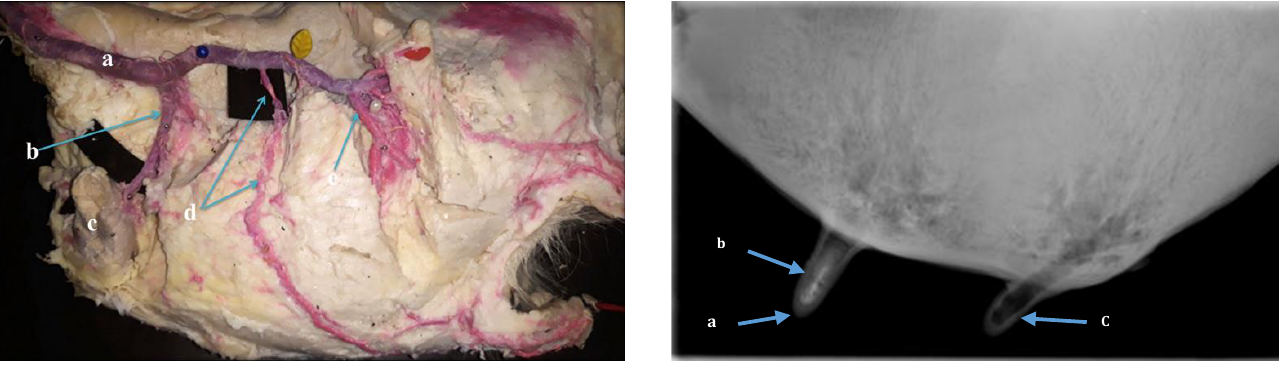
Figure 6. Radiographic picture of the fore quarter in non-lactating udder (1 mL of Iopromide contrast media) shows: (a) The teat orifice, (b) The teat canal, (c) Teat without contrast media